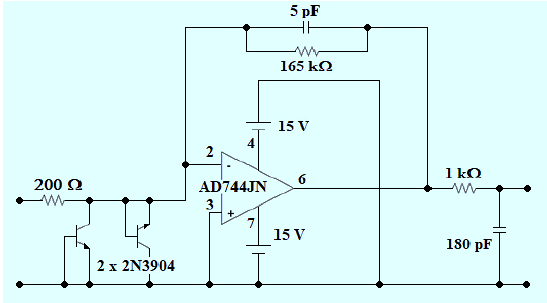
Figure 4. Signal conditioning